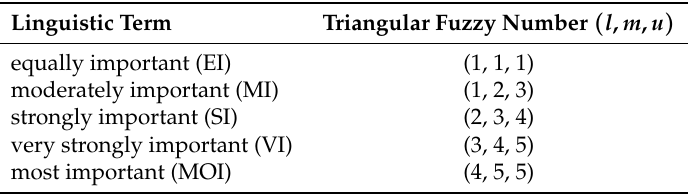
Table 1. Fuzzy rating in the FAHP